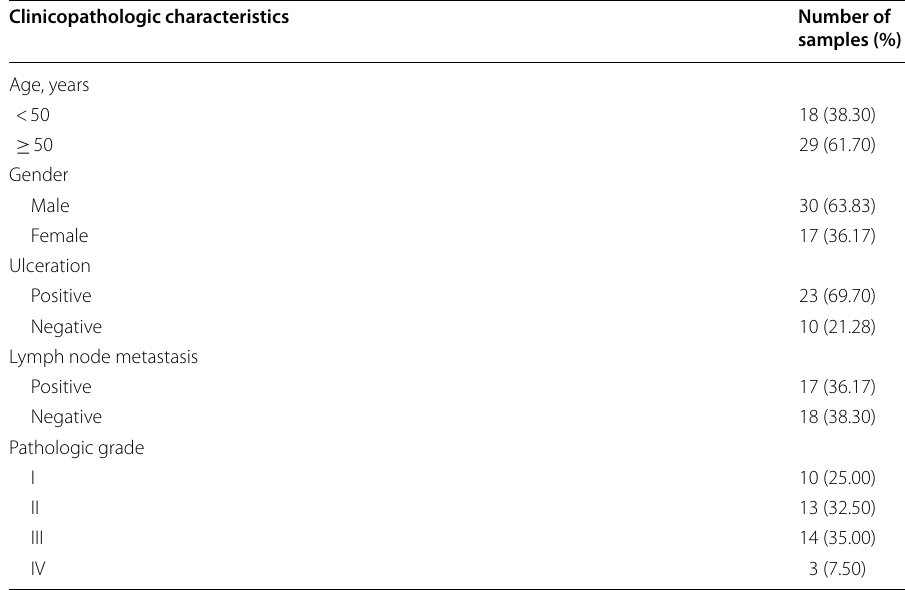
Table 1 Clinicopathologic characteristics of patients with melanoma Clinicopathologic characteristics